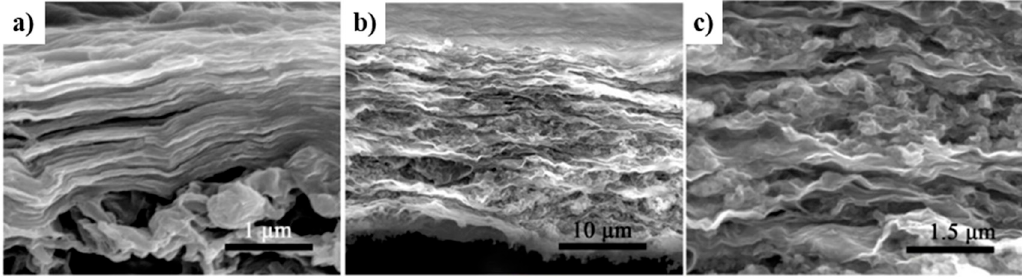
Figure 7. SEM images of GO/COF hybrid membranes: the cross-section of ( a ) a pure GO membrane and ( b , c ) a GO/COF 4:1.71 hybrid membrane. Reprinted with permission from [51]. Copyright (2020) Elsevier Ltd.